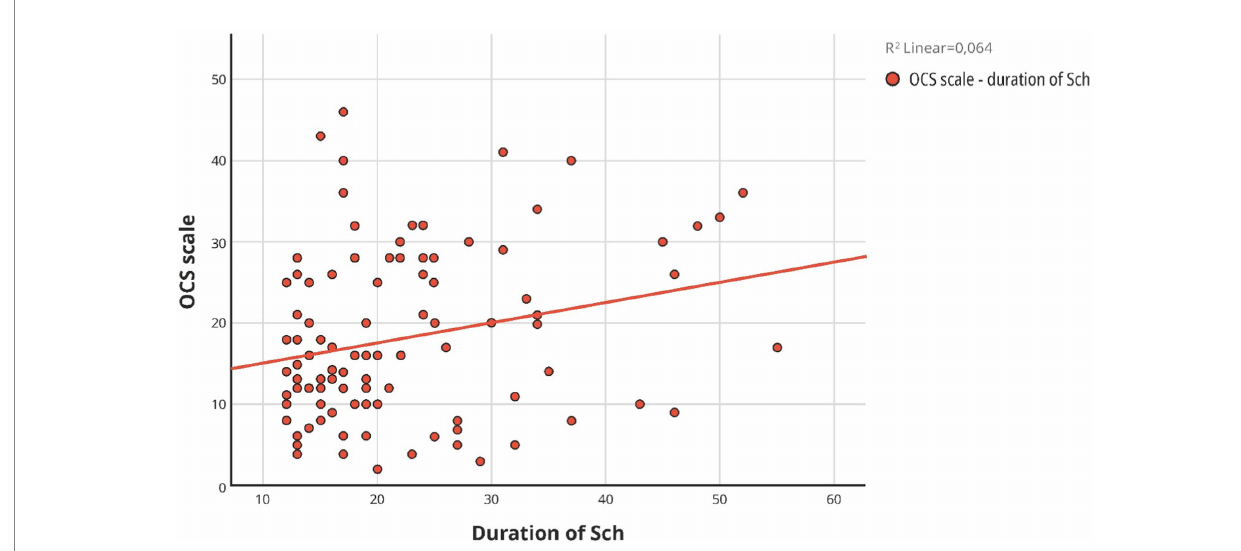
FIGURE 3 Simple Scatter with Fit Line of scale of OCS by duration of Schizophrenia.